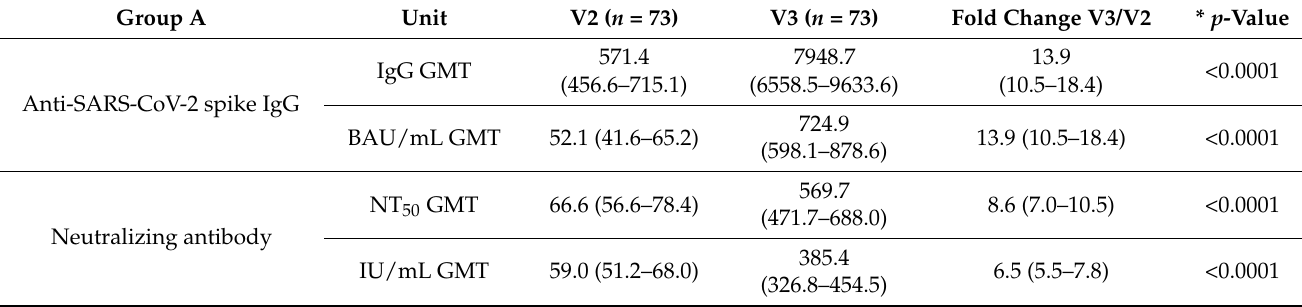
Table 3. Immunogenicity on the day of MVC-COV1901 booster (V2 for Group A, V3 for Group B) and one month after MVC-COV1901 booster (V3 for Group A, V4 for Group B) as measured by anti-SARS-CoV-2 spike IgG titers and live virus neutralizing antibody titers. GMTs are shown as GMT with a 95% confidence interval in the parentheses. Fold changes are calculated as the